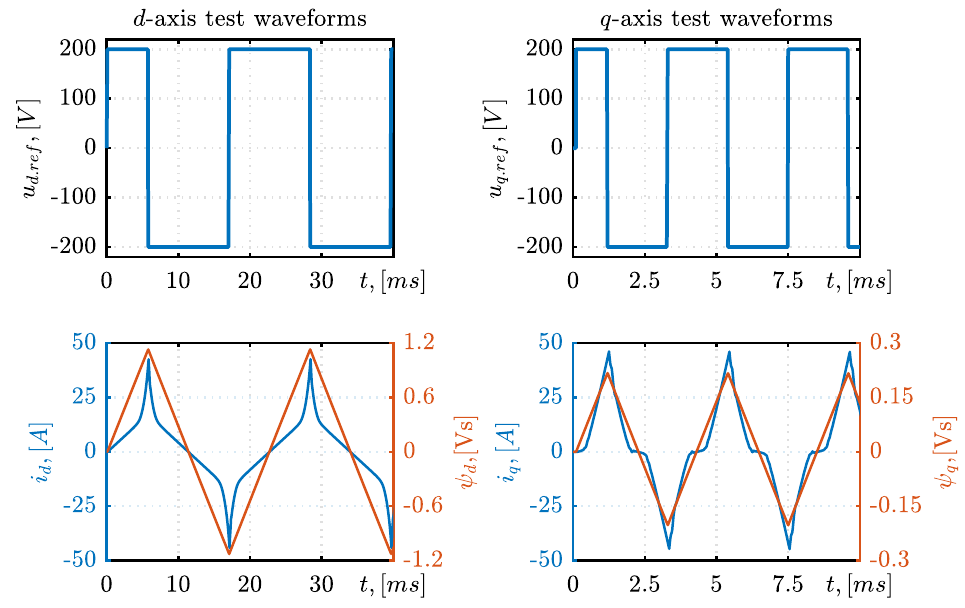
Figure 16. Self-axis test waveforms: d -axis left side and q -axis right side. During the identification of cross-saturation, the two axes are excited at the same time using the same approach as for self-saturation tests, as shown in Figure 17.